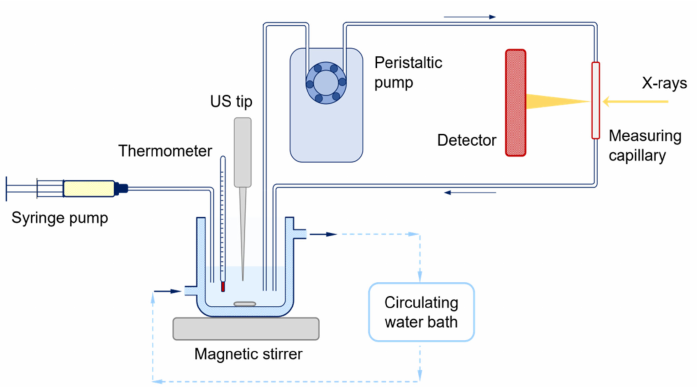
Figure 1. Schematic representation of the continuous-flow setup built at the SAXS beamline at Elettra Sincrotrone Trieste for the in situ time-resolved SAXS/WAXS study of MoO 3